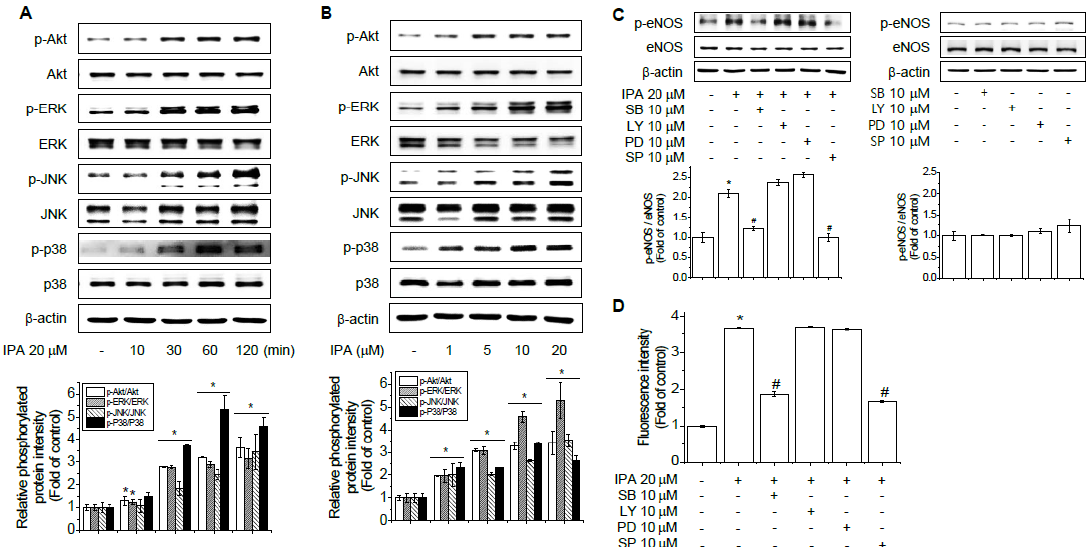
Figure 4. Akt and MAPKs related to eNOS activity and NO production in EA.hy926 cells induced by IPA. Immunoblots of EA.hy926 cell lysates treated with 20 μM IPA for 10, 30, 60, and 120 min ( A ) or with different concentrations of IPA (1, 5, 10, and 20 μM) for 60 min ( B ). EA.hy926 cells were treated with PD98059 (ERK1/2 inhibitor), SB203580 (p38 inhibitor), SP600125 (JNK1/2 inhibitor), and LY (PI3K/Akt inhibitor) for 1 h, followed by incubation with or without 20 μM IPA for an additional hour ( C ). NO production was analyzed with the NO-specific fluorescent dye DAF-2 DA kit at 495/515 nm ( D ). Data are means ± SD of three independent experiments. * p < 0.05 compared with control. # p < 0.05 compared with IPA treatment.